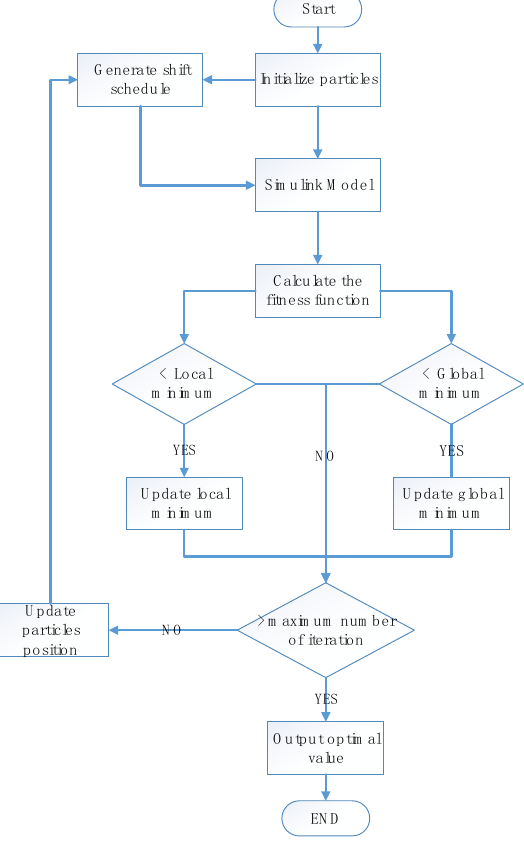
Figure 9. Optimization flow chart.